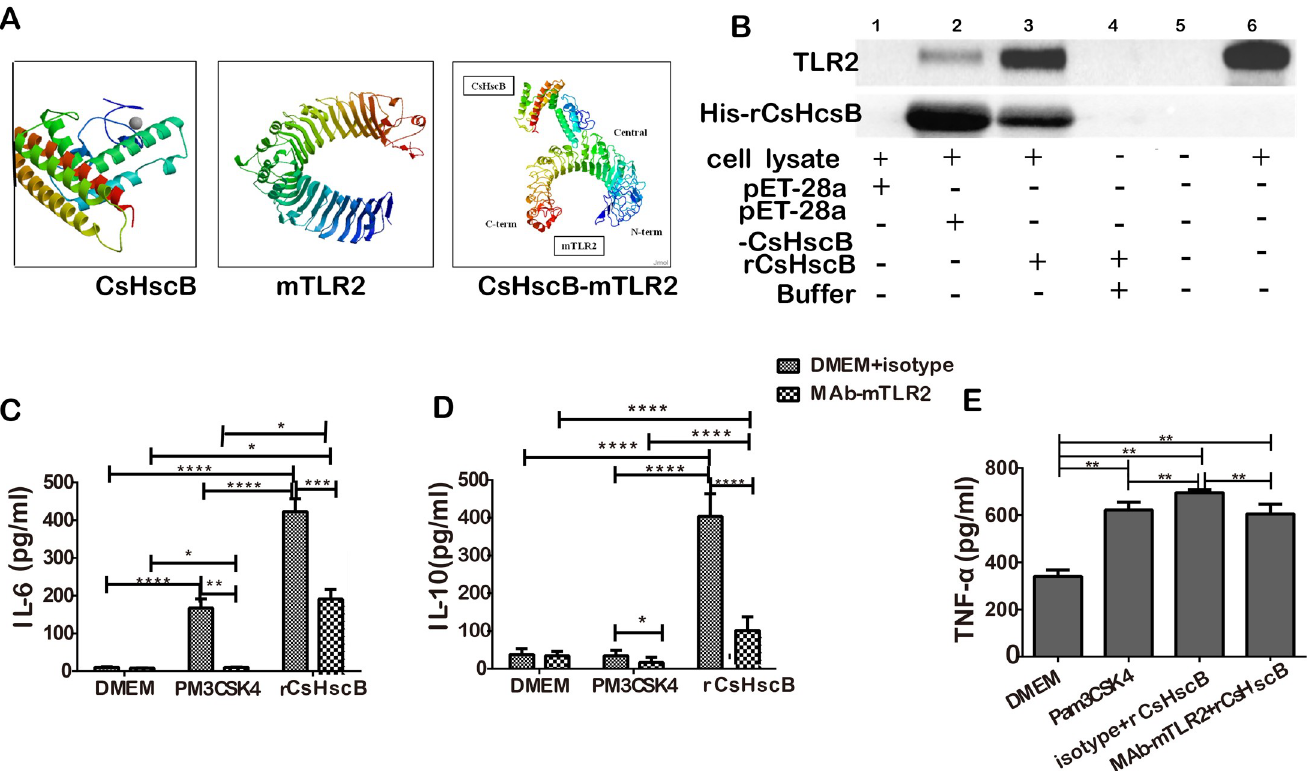
Fig 3. rCsHscB is a novel agonist for TLR2 to induce immune responses of macrophage. (A) Molecular docking analysis of binding TLR2 with CsHscB. (B) Pull- down assay analysis of the interaction of TLR2 and rCsHscB. The cells stimulated by supernatant of lysate from E . Coli transfecting with Vector controls (pET-28, His- tagged control, Lane 1), pET-28a-CsHscB vectors (pET-28-CsHscB, unpurified, Lane 2), purified rCsHscB-stimulated cells (Lane 3), binding buffer (Lane 4) and medium (Lane 6) for 24 h, the cells (from line 1~ line 5) were lysed and incubated with rCsHscB immobilized on Ni-NTA beads; bead-bound proteins (from line 1~ line 5) and cell lysates (line 6 without rCsHscB immobilized on Ni-NTA beads) were loaded onto a gel for immunoblotting for both TLR2 and rCsHscB. Lane 5 represents negative control for pull-down assay; line 6 represents positive control for TLR2. (C~E) The production of IL-6 (C) , IL-10 (D), and TNF- α (E) were hindered in rCsHscB-stimulated cells when TLR2 was blocked by a neutralizing antibody of TLR2. PM 3 CSK 4 was used as TLR2 ligand for positive controls. Quantitative data are representative of mean ± SEM of at least three independent experiments (n = 4). � P < 0.05, �� P < 0.01, and ��� P < 0.001 compared with indicated